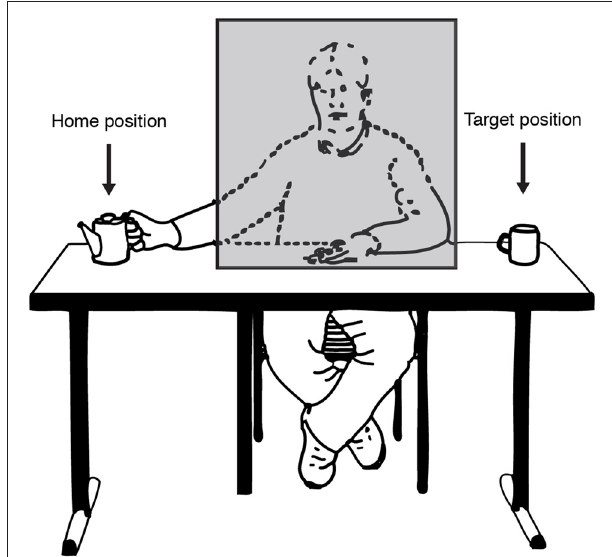
FIGURE 5 | Illustration of the experimental setting as seen through the eyes of the participant. On each trial the actor (sitting behind an occluding object) transported a teapot from a home position to a target position. Figure adapted from Prinz and Rapinett (2008) (p. 226). Copyright by IOS Press. Adapted with